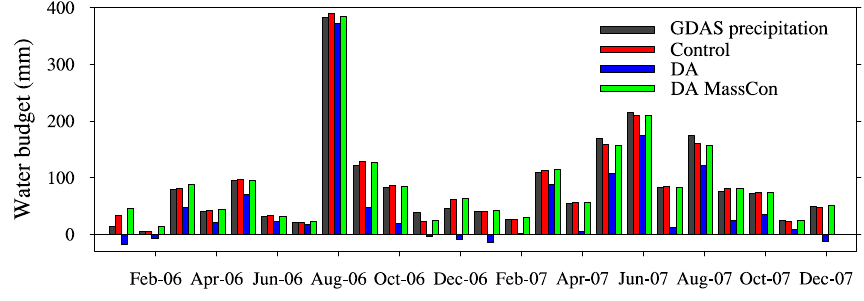
Fig. 10. Monthly GDAS precipitation and water budget for Control, DA and DA